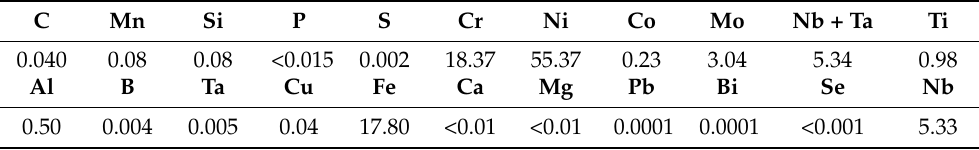
Table 1. Chemical composition of IN718.